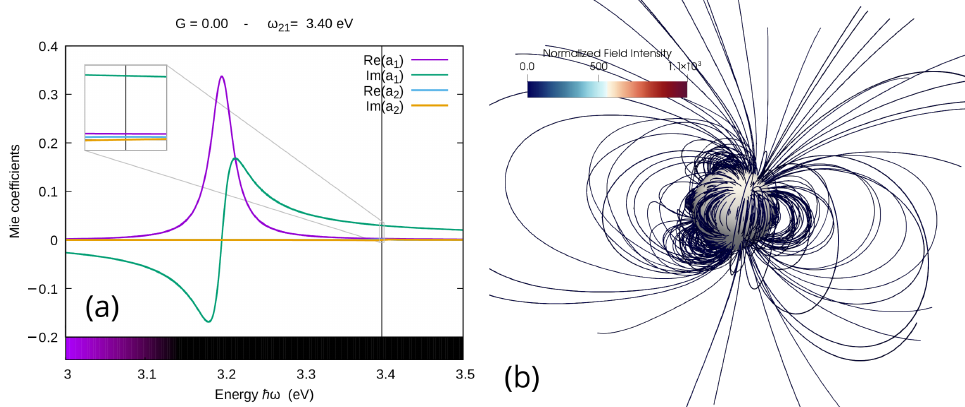
Figure 6. ( a ) Spectra for the real and imaginary part of the first two coefficients of the Mie expansion of the scattered field for a silver nanoparticle of radius 60 nm in water when no gain is added to the system, the inset in the upper left corner is a zoom around the resonance frequency of the second coefficient; ( b ) streamlines of the scattered field calculated for the quadrupolar central frequency ¯ h ω = 3.4 eV, and the colorbar range here is the same as Figure 8b.